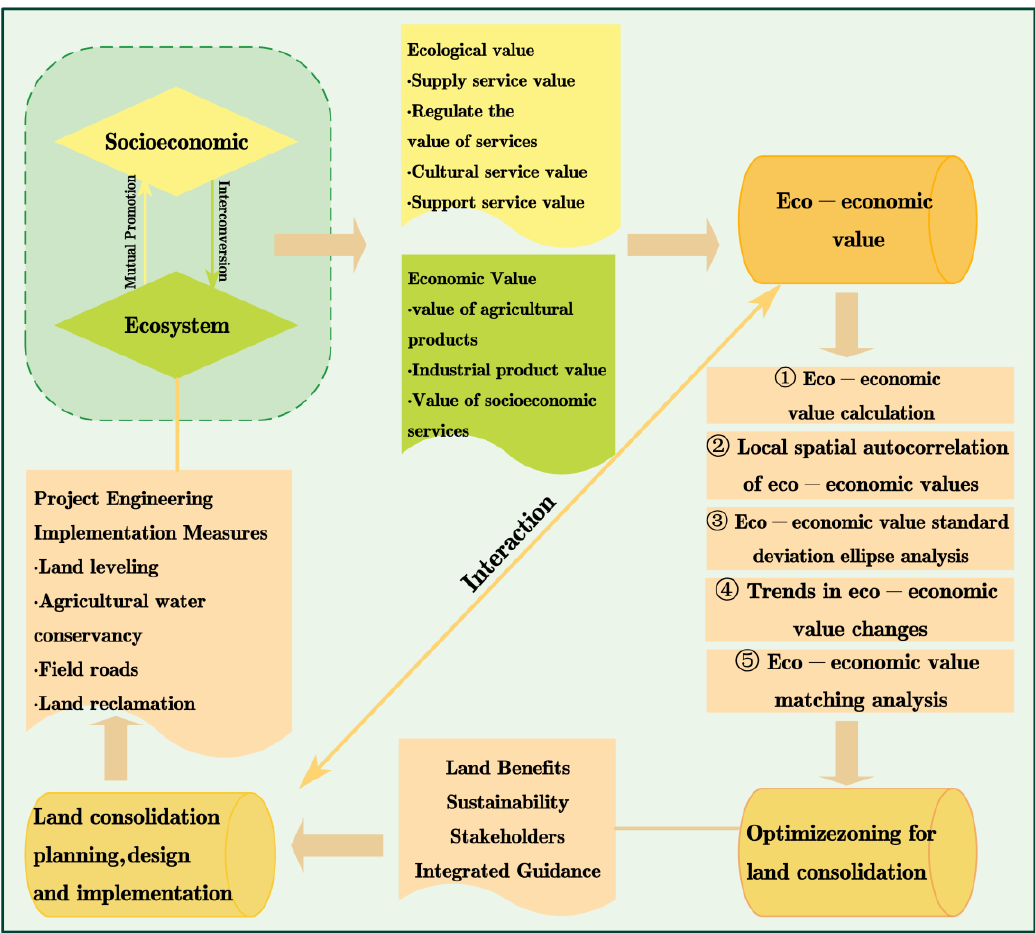
Figure 2. A framework for linking land reclamation and ecological-economic